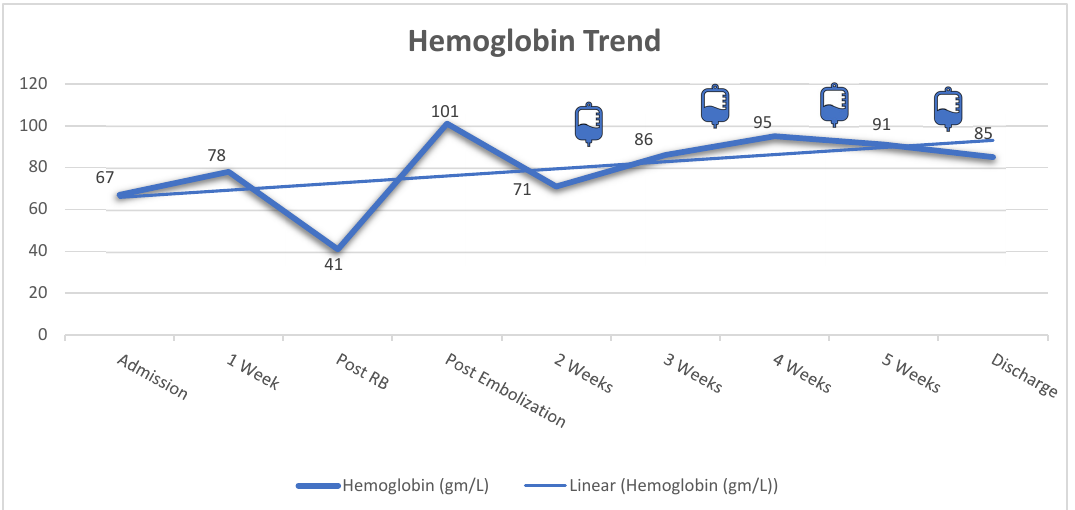
Figure 2. Trend of hemoglobin level during hospital course. The infusion bag icons correlate with the time of each rituximab dose. The patient had a signi fi cant drop in his hemoglobin level (41 gm/L) with perinephric hematoma post renal biopsy. Therefore, the left renal artery was successfully em- bolized, resulting in signi fi cant improvement in the patient’s hemoglobin level (101 gm/L). RB: renal biopsy.